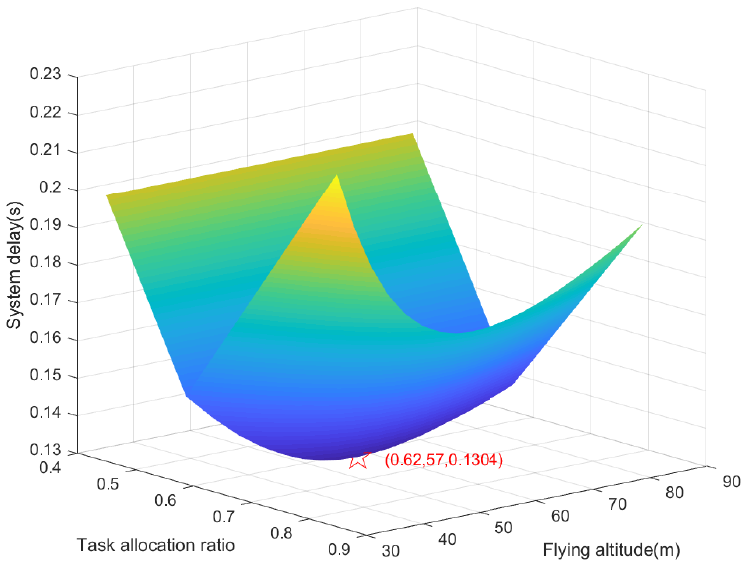
Figure 2. Total system delay versus task allocation ratio and flying altitude.